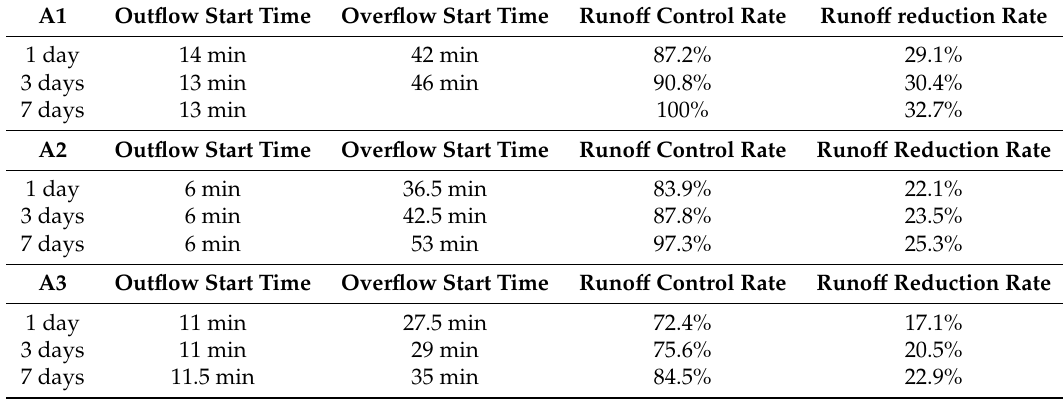
Table 4. Control e ff ects of runo ff of each bioretention system under di ff erent rainfall intermittent